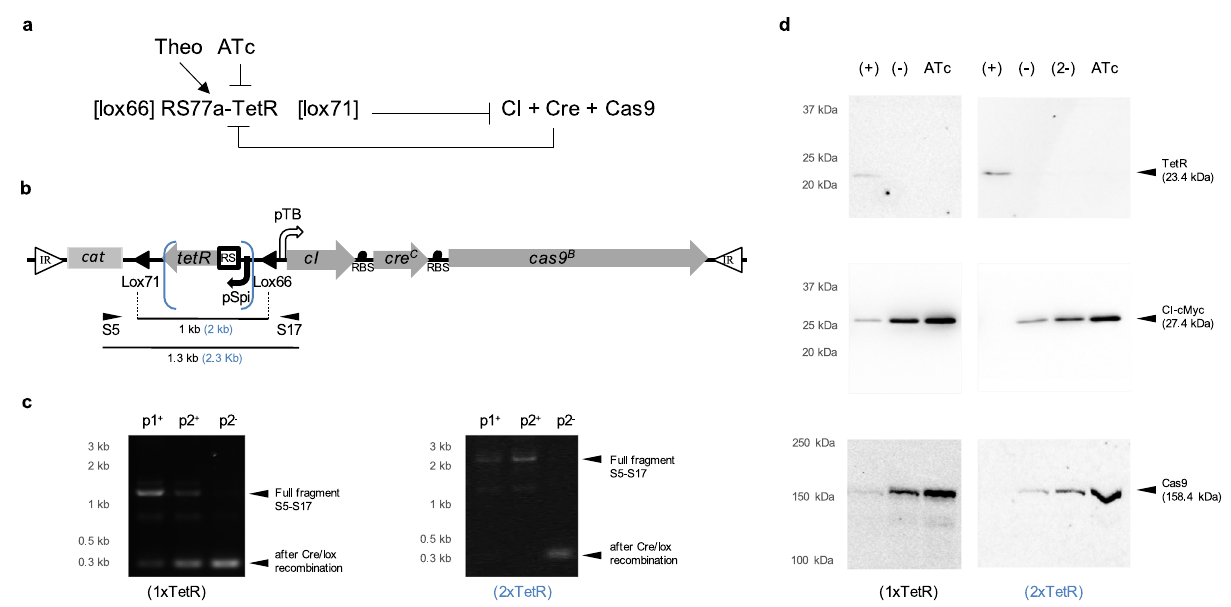
Fig. 3 Design and characterisation of circuit TKS2. a Schematic representation of the circuit TKS2. Blunt arrows indicate repression and pointy arrow activation. b Schematic representation of relevant DNA segments of the MTn cat with TKS2 used to generate a polyclonal strain (chloramphenicol used for selection). White triangles for the inverted repeats (IR); Bend-arrows for constitutive promoters (black) and ATc-inducible (white) promoters. Arrows for genes (grey); Black semicircles show the RBSs; A white square for the riboswitch (RS); Black triangles indicate the position and orientation of the lox sites (lox66 and lox71); cat , selection cassette. Blue brackets indicate the segment that is duplicated in the analysis of the circuit with 2xTetR cassette. c DNA gel showing the results from the PCR analysis of Cre/lox recombination in the TKS2 from genomic DNA samples from passages 1 and 2 in theophylline medium with Cre basal expression (p1 + and p2 + ) and passage 2 in theophylline-free medium and Cre induction (p2-). PCR product size is expected for the full fragment, before Cre/lox recombination, and the distance between lox sites are indicated in (b) between the small head arrows S5 and S17, showing the position of the primers pair used in the assay (in blue for 2xTetR). d Western blot results showing TetR, CI and Cas9 expression in strains with the circuit TKS2. Expression of the proteins was analysed using 10 µ g of total protein extracts from incubations of the strains in the growth permissive condition of 0.5 mM theophylline ( + ); after a single passage in theophylline-free medium producing slow activation of the TKS2 ( − ); after two passages in theophylline-free medium (2 − ) or in 50 ng/mL of ATc to trigger the kill-switch (ATc). Results presented from the circuit engineered with one or two copies of the pSpi-riboswitch-tetR cassette between the lox pair sites in the circuit (1xTetR or 2xTerR, respectively). DNA gel and western blot results are representative of two independent experiments in each